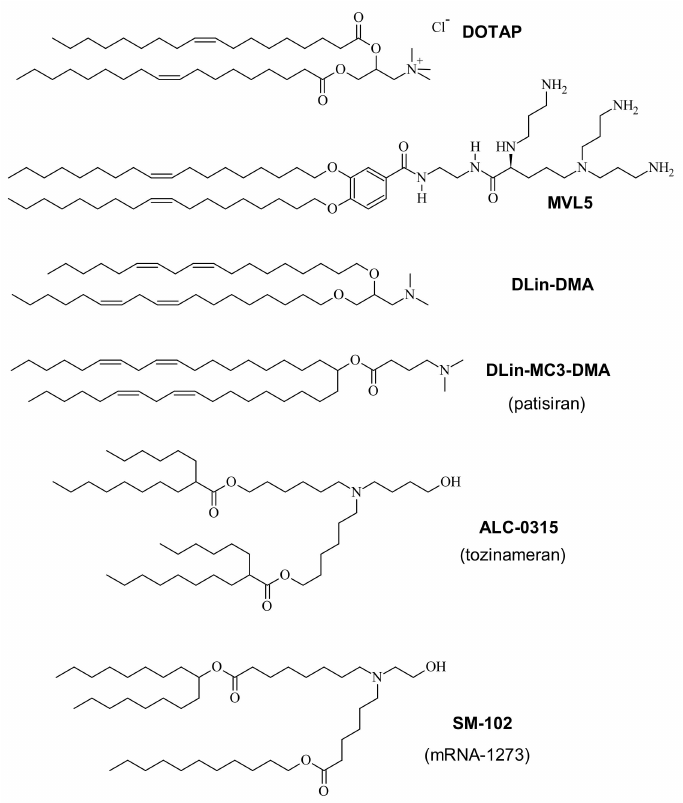
Figure 2. Structures of the cationic lipids DOTAP (1+; 1,2-dioleoyl-trimethylammonium propane chloride) [83], MVL5 (5+) [84], DLin-DMA [85], and the cationic lipids used in FDA-approved